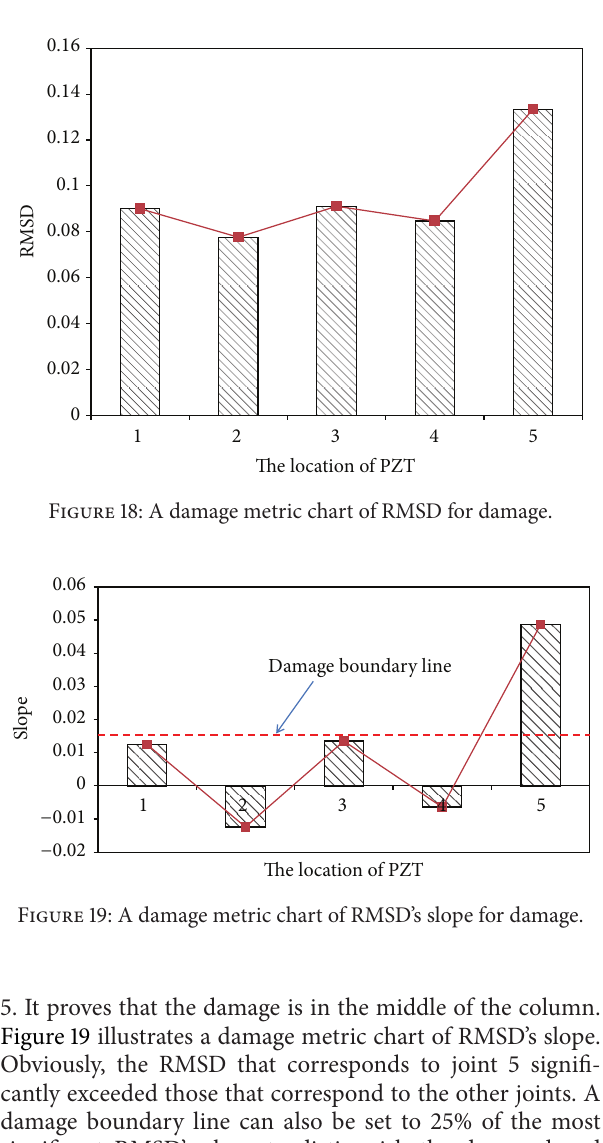
5. It proves that the damage is in the middle of the